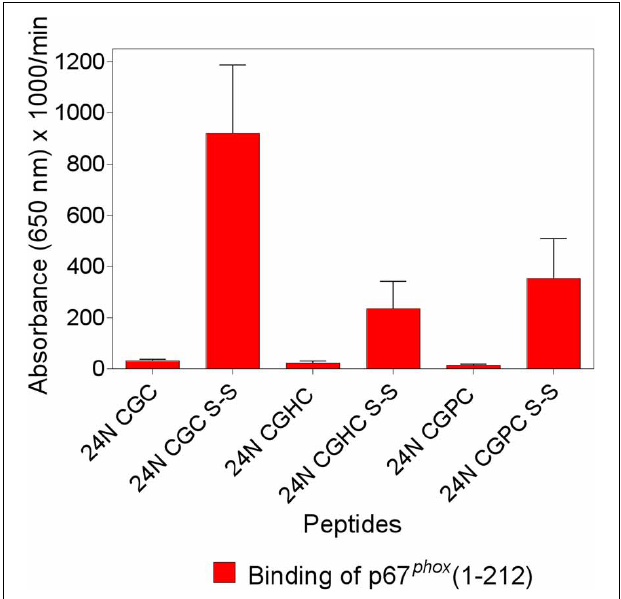
FIGURE 1 | The enhanced binding of p67 phox to Nox2 peptides with an intramolecular disulfide bond is maximal when the cysteines are separated by a single glycine. The binding of p67 phox (1–212), in solution, to surface-attached native and modified Nox2 peptide 24 (357–371), with an N-terminal biotin tag, was measured. The native peptide comprises the 369 CysGlyCys 371 triad at the C-terminus, in the dithiol form (labeled 24N CGC), and a disulfide form was synthesized, with an intramolecular disulfide bond between cysteines C369 and C371 (labeled 24N CGC S-S). Two more peptides were synthesized in which the CGC triad was replaced with CysGlyHisCys (labeled 24N CGHC) or CysGlyProCys (labeled 24N CGPC), to mimic the catalytic sites of PDI and thioredoxin, respectively. These two peptides were also synthesized in the dithiol form and with an intramolecular disulfide bond between cysteines 369 and 372. The methodology is described in the Materials and Methods Section. Results represent means ± SEM of three